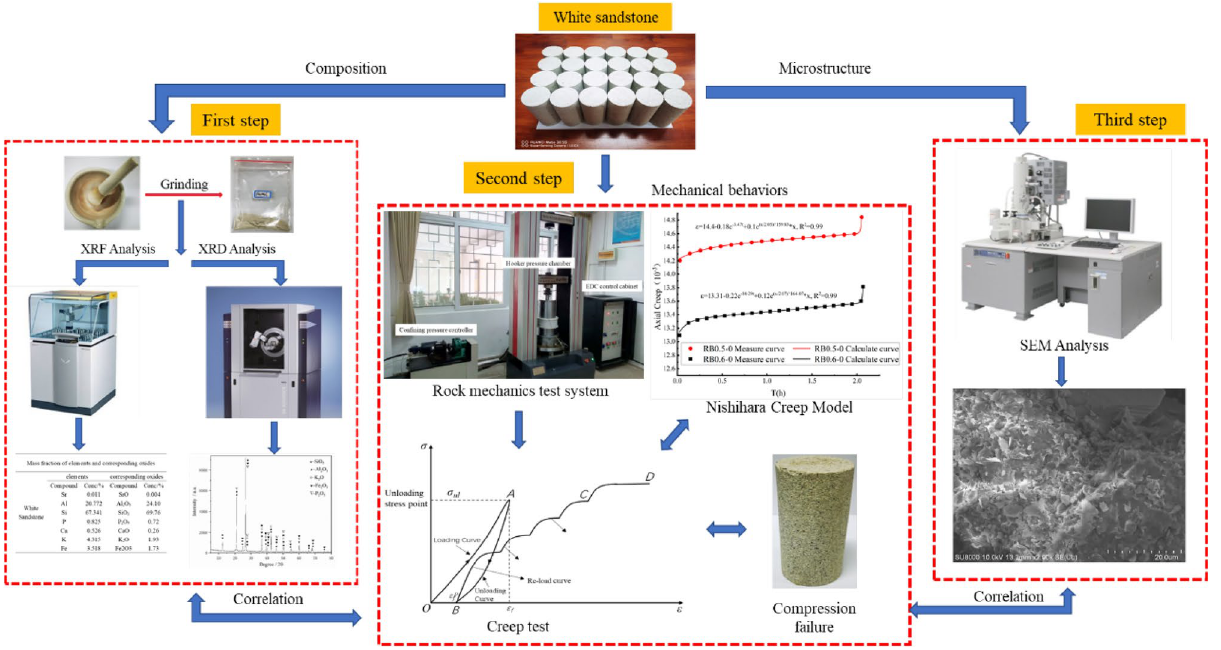
Figure 3. Experimental scheme for macro- and mesoscopic failure and uniaxial creep testing of white